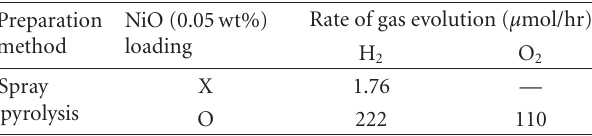
Table 2: E ff ect of NiO loading on photocatalytic activities for water splitting in pure water over NaTaO 3 (NaTaO 3 powder synthesized by spray pyrolysis; mean residence time = 1.80 seconds; spray pyrolysis temperature = 1173 K; precursor preparation temperature = 333K; precursor concentration = 0.125 M; carrier gas (air) flow rate = 5 L/min; Na/Ta = 1.00; reaction conditions: amount of distilled water, 500ml; photocatalyst concentration = 1.0gL − 1